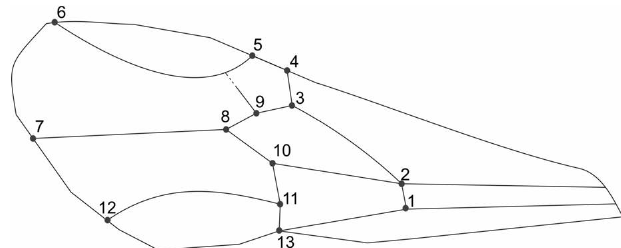
Fig 1 . Left forewing showing the anatomical landmarks used in mor - phometric